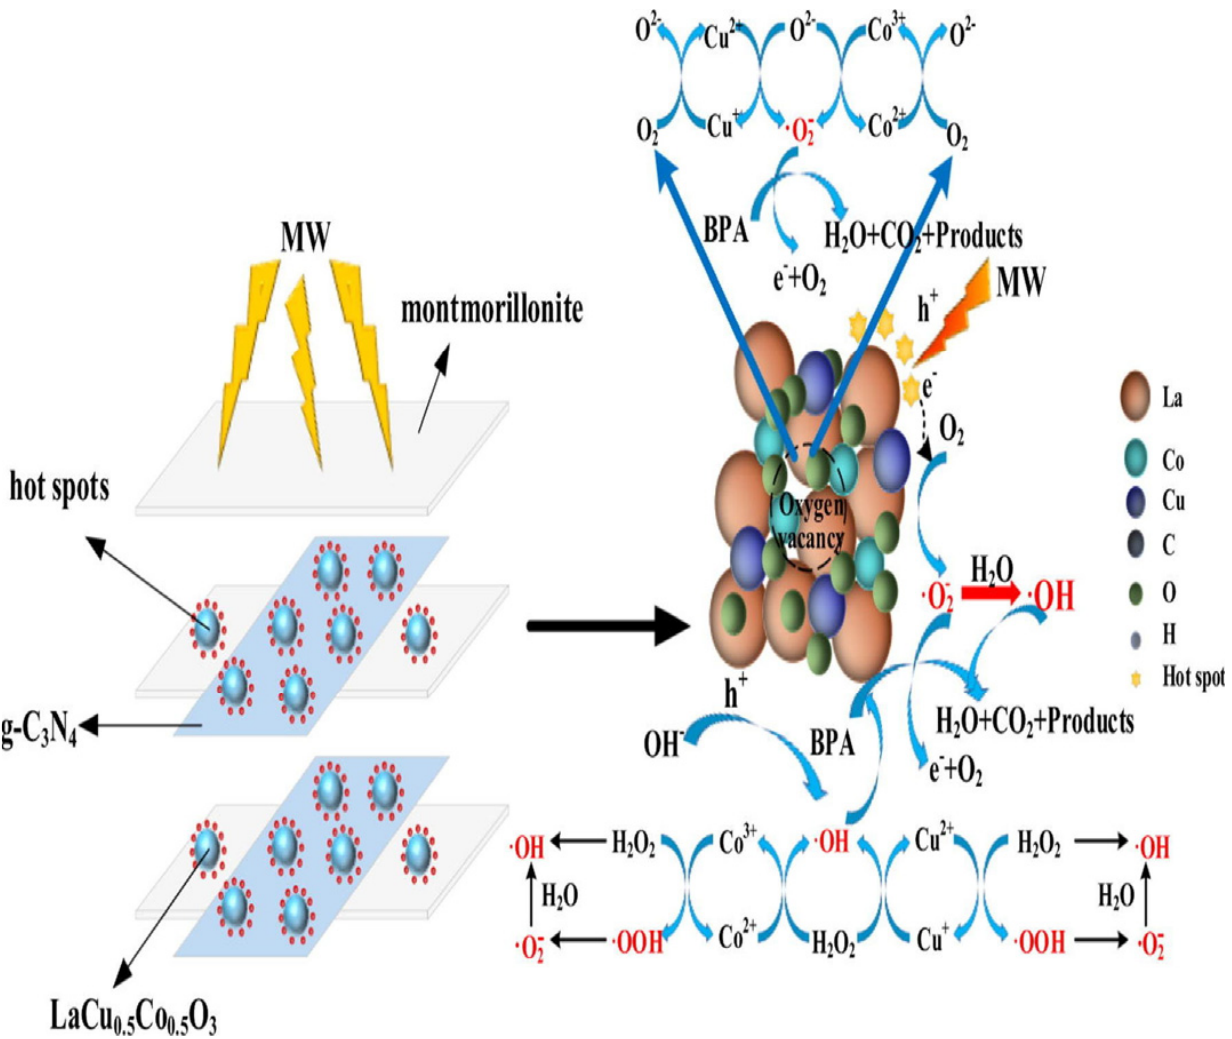
Figure 2. Possible BPA degradation mechanism over LCCOM